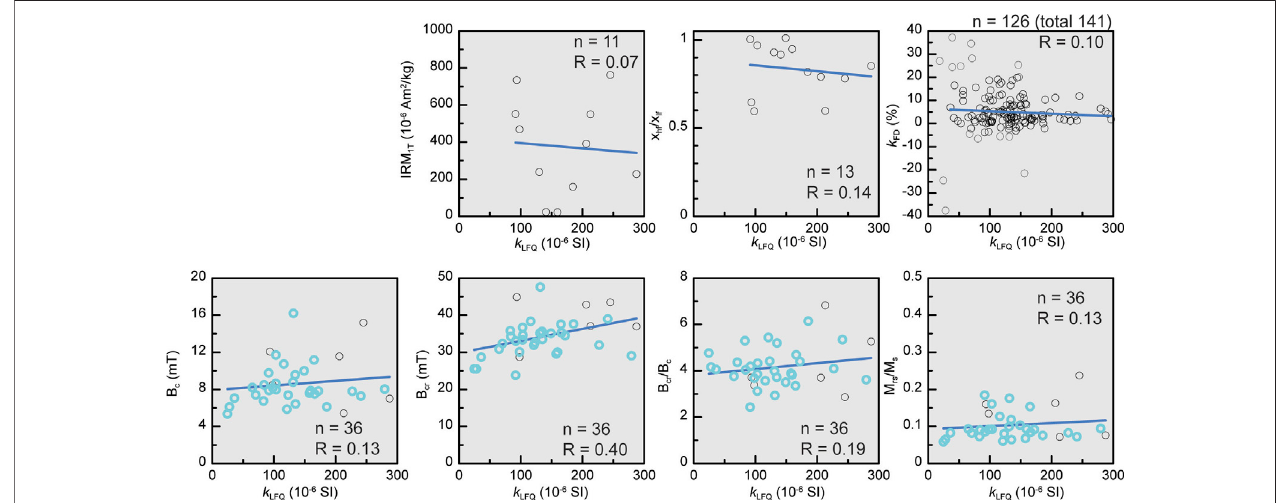
FIGURE 6 | Biplots of k LFQ vs. each of several other magnetic properties (IRM 1T , χ hf / χ lf , k FD , B c , B cr , B cr /B c and M rs /M s ). k LFQ all were from bulk sediment samples. For the respective biplots, a fi t line and its corresponding correlation coef fi cient (R) is provided. Black (Cyan) circles denote the data where the magnetic property values wereobtainedfromthebulk(extract)samples.Forthe k LFQ vs. k FD plot,thedatathatwereinoutoftherangebetween − 5and20in k FD (graycircles),beingregardedless reliable, were excluded when consdiering the correlation degree between k LFQ and k FD